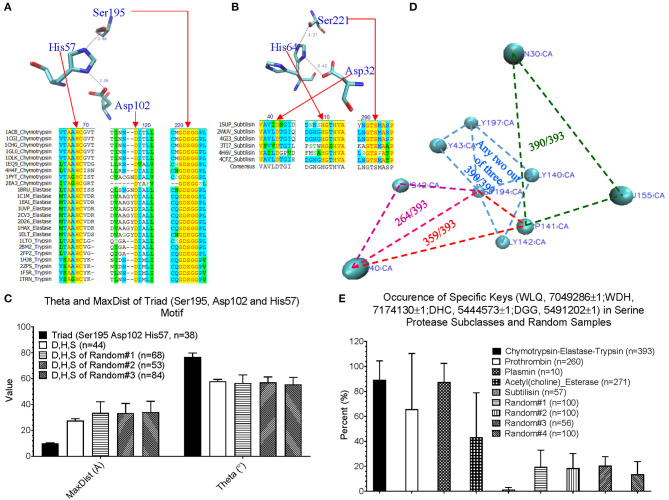
An impact of our method in motif identification and discovery of serine proteases. (A) The sequence alignment of the representative digestive serine proteases: chymotrypsin, trypsin and elastase, and a representative triad of chymotrypsin; (B) The sequence alignment of the representative subtilisins, and a representative triad of subtilisin; (C) The Theta and MaxDist for triad of serine proteases, and all the triangles formed by Asp, His, and Ser of the serine proteases and three sample sets randomly selected from PDB were calculated. Average, standard deviation and the number of proteins are indicated; (D) The representative triangles corresponding to the keys: 7049286 (green), 7174130 (red), 5444573 (pink), and 5491202 (light blue) are shown (PDB ID: 4H4F). Numbers of chymotrypsin-elastase-trypsin out of a total 393 having the keys are shown; (E) The percentage of occurrence of the keys: 7049286, 7174130 5444573, and 5491202 were calculated. Average, standard deviation and number of proteins are indicated. Key value difference by 1 (±1) allows minor flexibility for Theta to be considered as presence of the given key. This applies for all other figures where ±1 is specified.